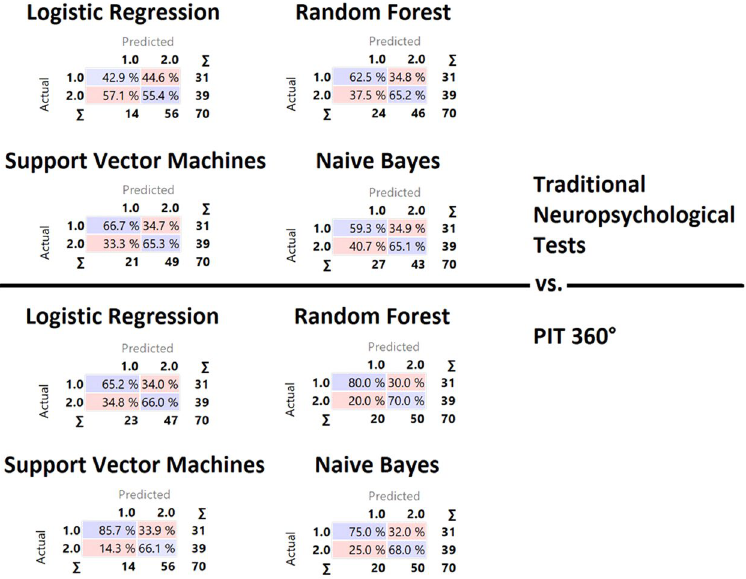
Figure 1. Confusion matrix. The confusion matrix of all classifiers computed for the classification into “HC Group” and “PwMS Group”. The values on the diagonal (i.e., purple values) indicate the elements for which the predicted group is equal to the true group, while off-diagonal values are those that are mislabelled by the classifiers. Results showed that PIT 360° had a higher capability for correctly classifying PwMS in their group with respect to traditional neuropsychological tests of executive